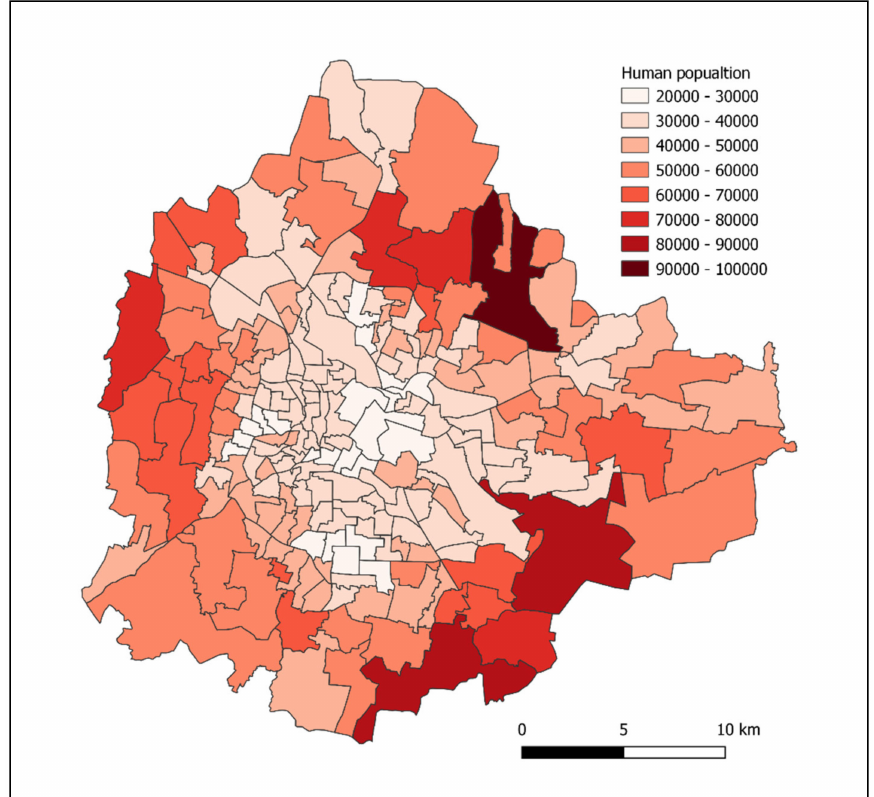
Figure 6. Map showing human population by ward (India census 2011), which would be the basis for team direction using campaign management technology, such as WVS App, although further division into smaller Working Zones denoting a team’s area of work for a few days would likely be